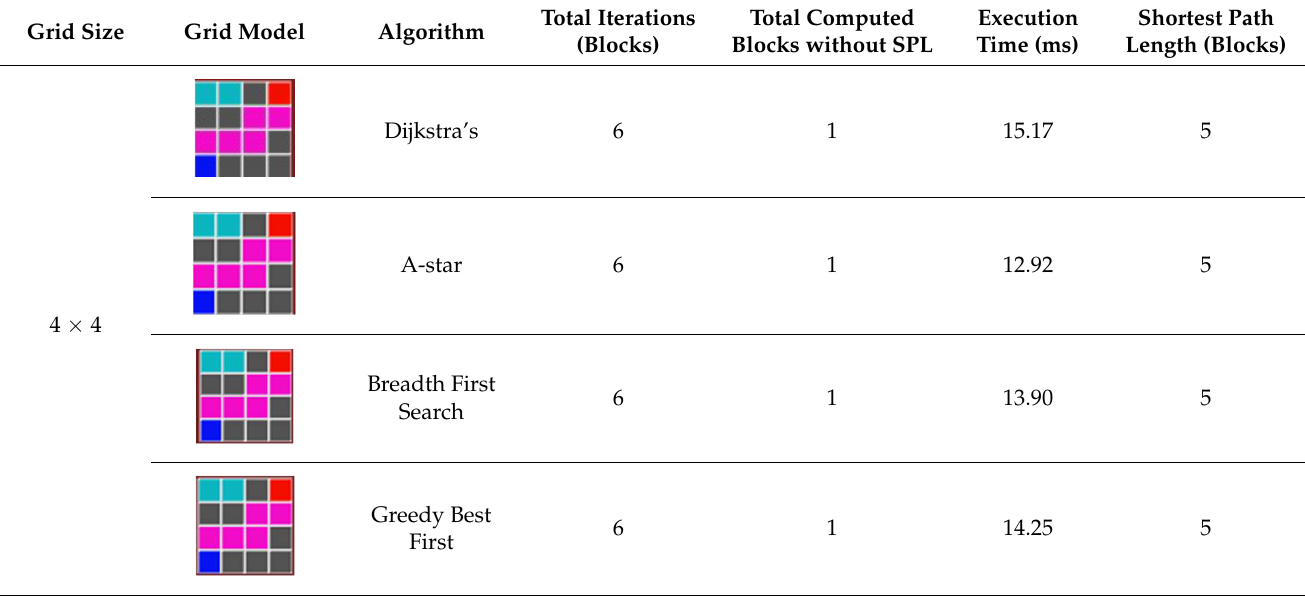
Table 4. Performance analysis of pathfinding Algorithms with obstacles.